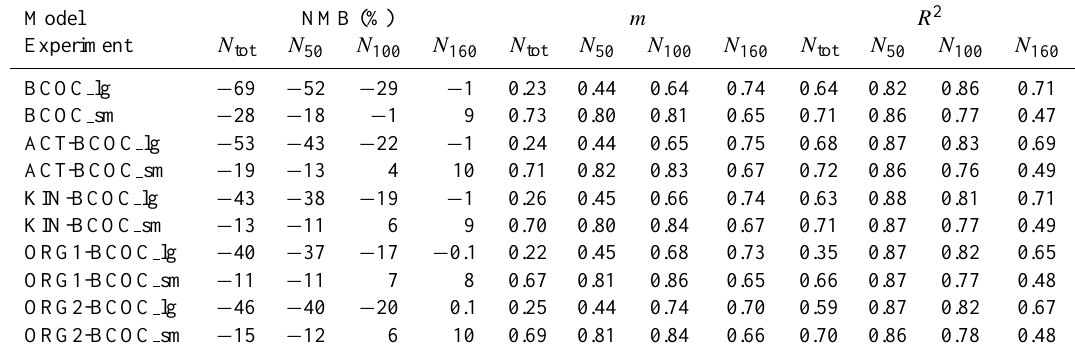
Table 3. Summary statistics for total particle number concentrations ( D p > 15nm; N tot ) and for concentrations of particles in three size- ranges typical for CCN; D p > 50nm ( N 50 ), > 100nm ( N 100 ) and > 160nm ( N 160 ). The normalised mean bias (NMB), slope of the linear regression ( m ) and correlation coefficient ( R 2 ) are calculated between the simulated and observed campaign-mean number concentrations at each ground